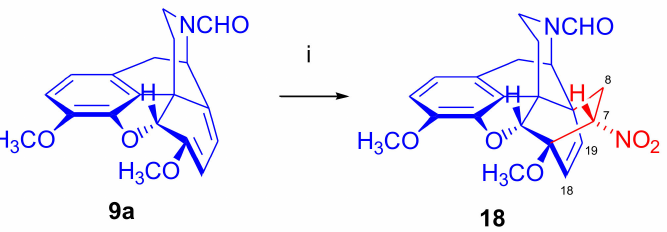
Figure 7. Reaction of N 17 -formyl-northebaine with nitroethene. Reagents and conditions : (i): ni- troethene, benzene, boiling, 19 h.